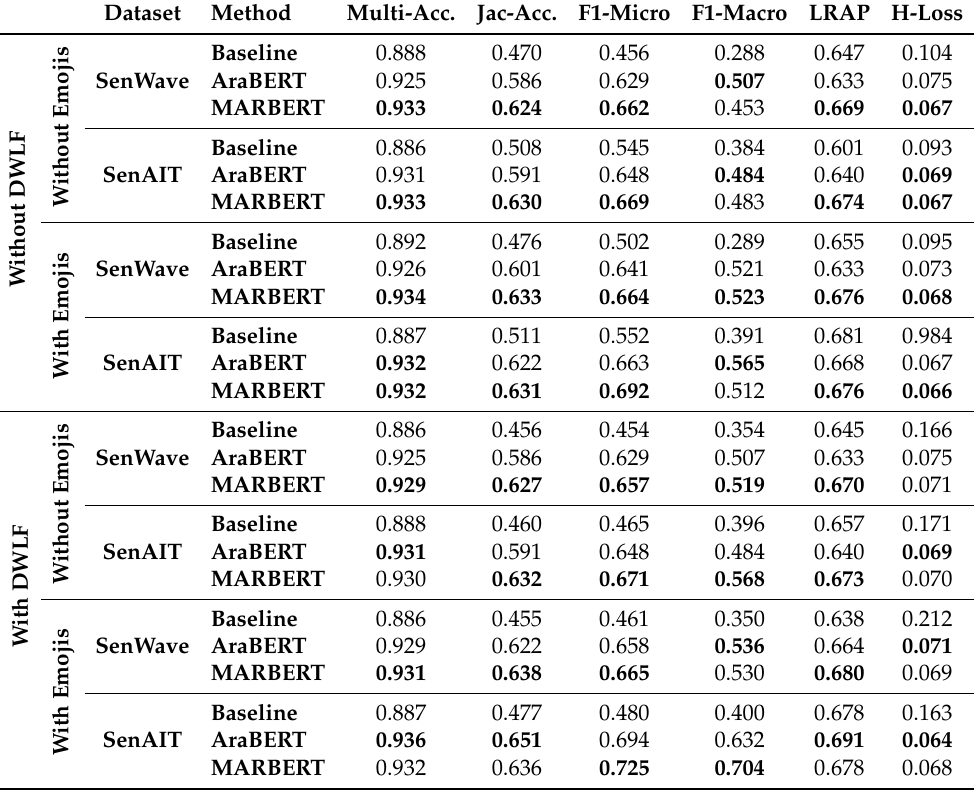
Table 3. Performance of the proposed